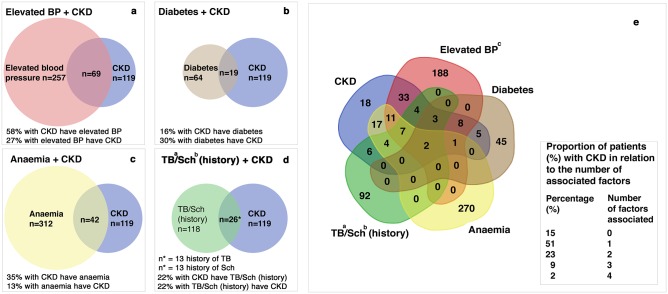
Venn diagram for interaction between chronic kidney disease and associated factors.(a-d) Relationship between associated factors and chronic kidney disease (CKD). Overlapping areas: patients with CKD and a single associated factor and vice versa; (e) Interaction between the four associated factors,—elevated BP (red), diabetes (brown), anaemia (yellow) and history of schistosomiasis/tuberculosis (green) -, in relation to CKD (blue). The numbers indicate patients with CKD, one or more associated factors and overlap between CKD and associated factors. Of all CKD cases 85% (n = 101) are overlapping at least one associated factor, 15% (n = 18) are not associated to one of these factors. a TB: tuberculosis bSch: schistosomiasis; cElevated BP: elevated blood pressure (≥140/90 mmHg); CKD: chronic kidney disease (eGFR <60ml/min/1.73m2 or albumin-to-creatinine ratio (ACR) ≥30mg/g (≥3mg/mmol)).